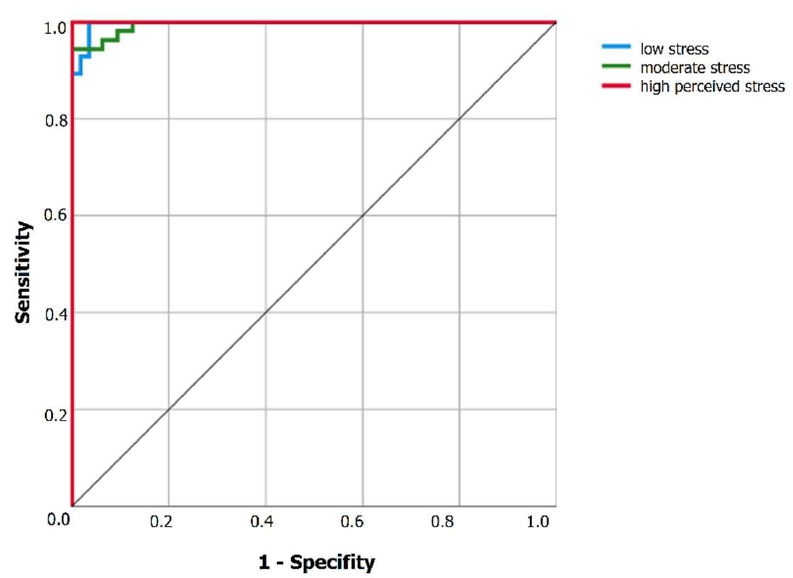
Figure 3. ROC curve for the ANN2 model.